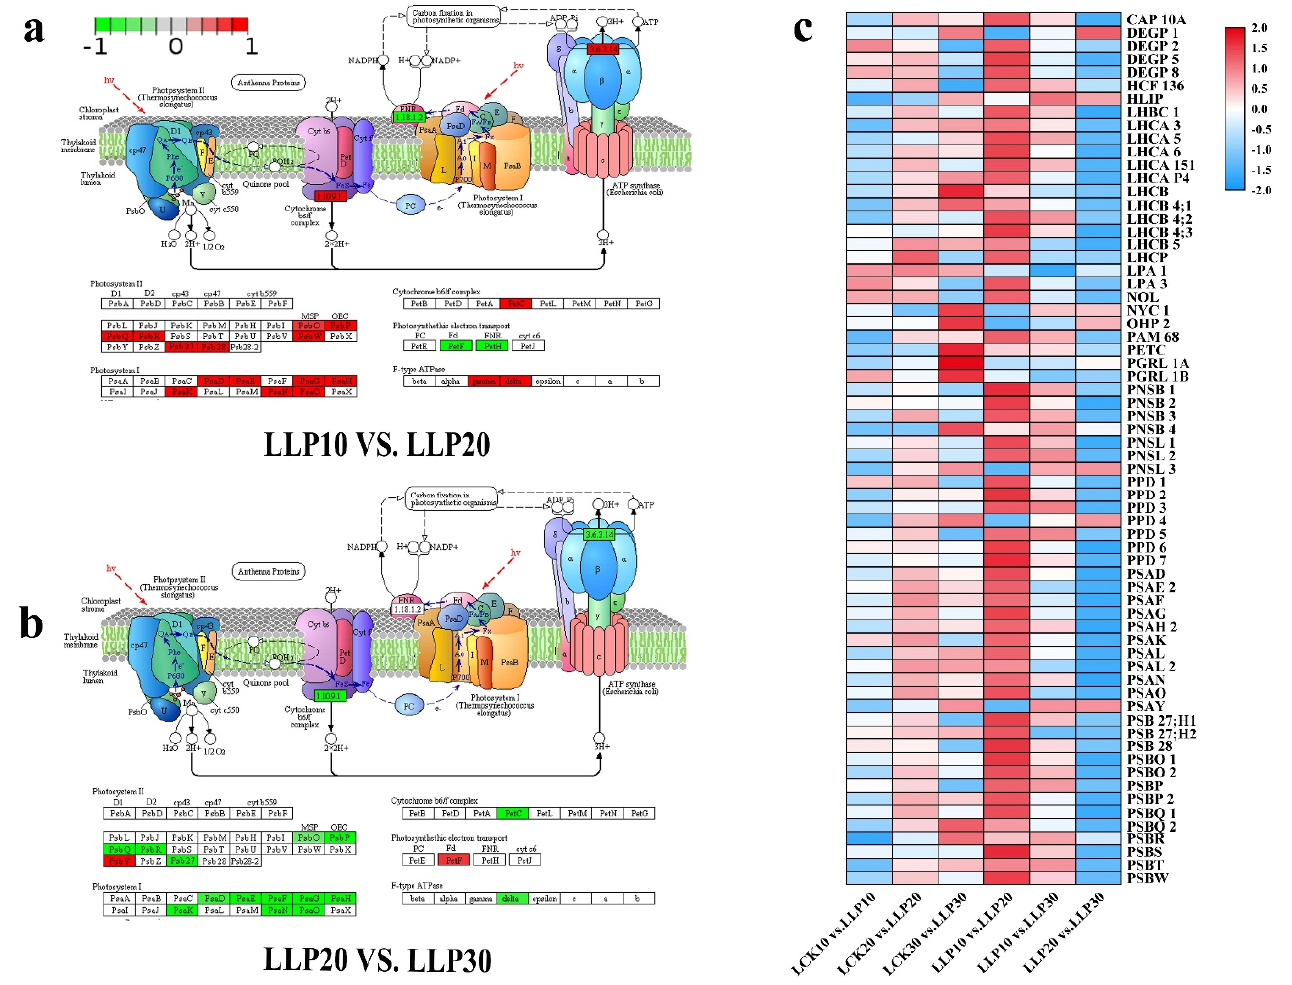
Figure 10. DEGs involved in the photosynthesis pathway of M. mandshurica leaves under low − Pi treatment. ( a ) LLP10 vs. LLP20 and ( b ) LLP20 vs. LLP30. ( c ) Heat map of photosynthesis related DEGs. Red represents up − regulated, blue represents down − regulated, and white represents the value of log 2 (FPKM+1) was zero.